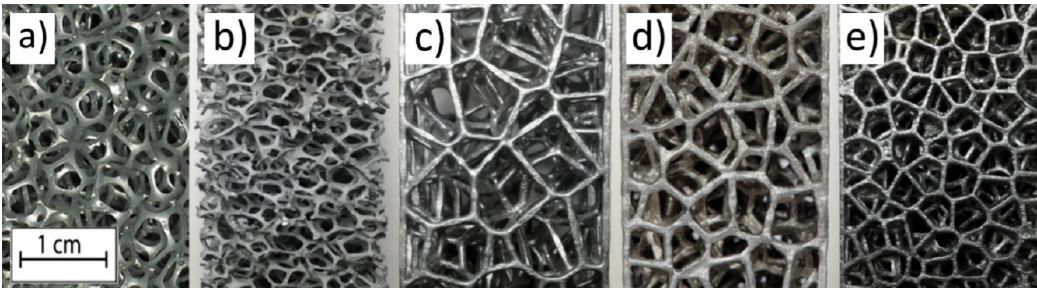
Figure 4. Metal foams object of this work: ( a ) m.pore ® , ( b ) duocel ® , ( c ) 5 pores-per-inch (PPI) designed, ( d ) 7 PPI designed, and ( e ) 10 PPI designed.